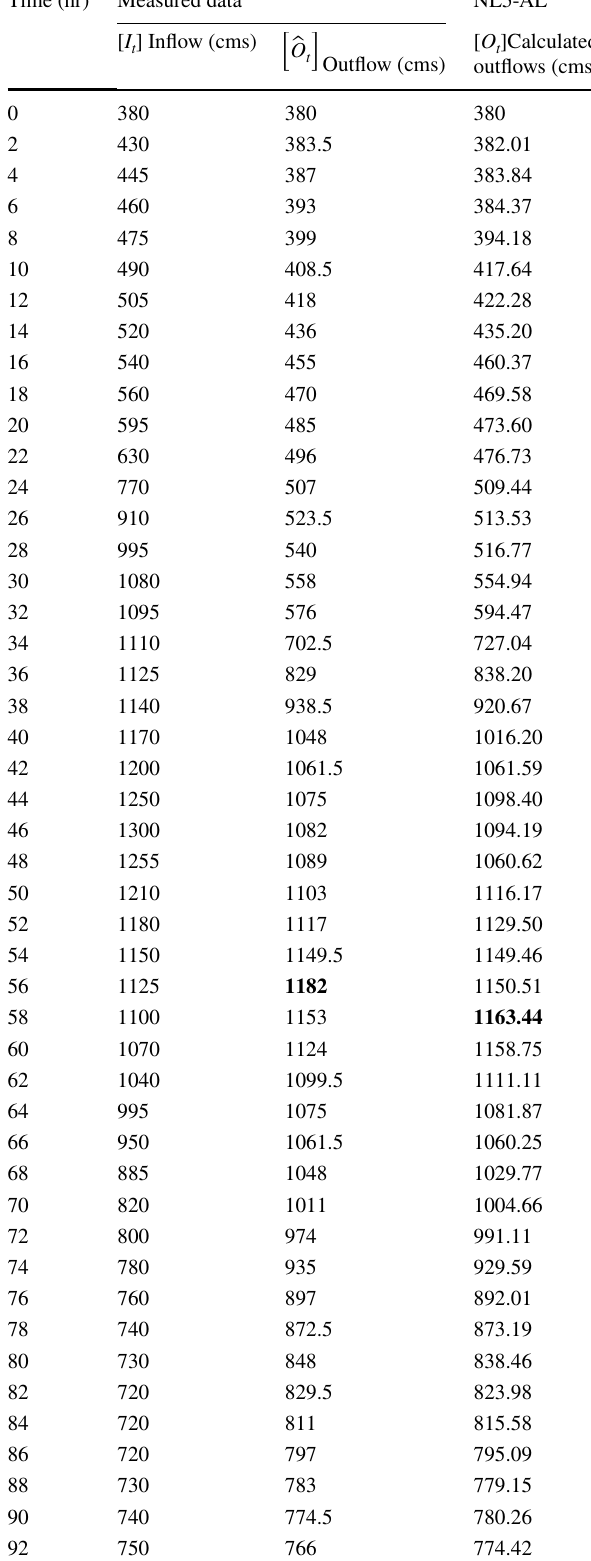
Table 5 Results related to the fifth example (Karun flood data) Time (hr) Measured